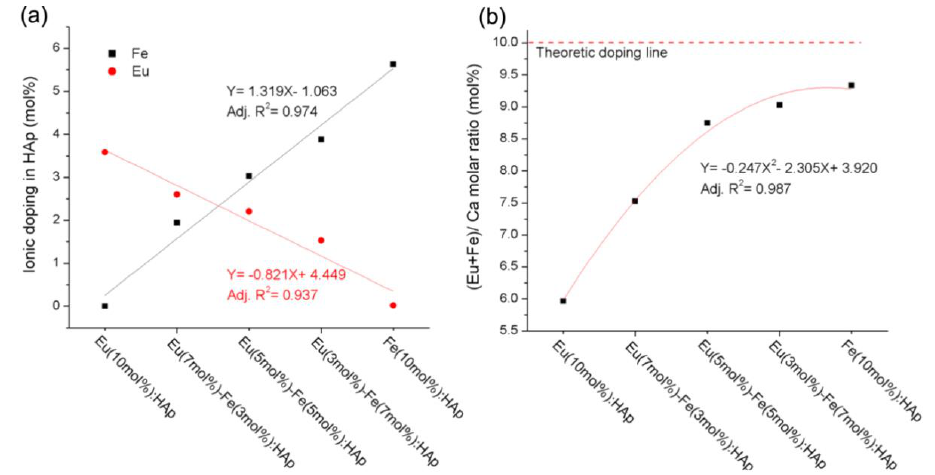
Figure 10. The ICP-AES (Inductively Coupled Plasma Atomic Emission Spectroscopy) results: ( a ) Eu 3+ and Fe 3+ doping amount; ( b ) (Eu + Fe)/Ca molar ratio of hydroxyapatite with different dopant concentrations [38].